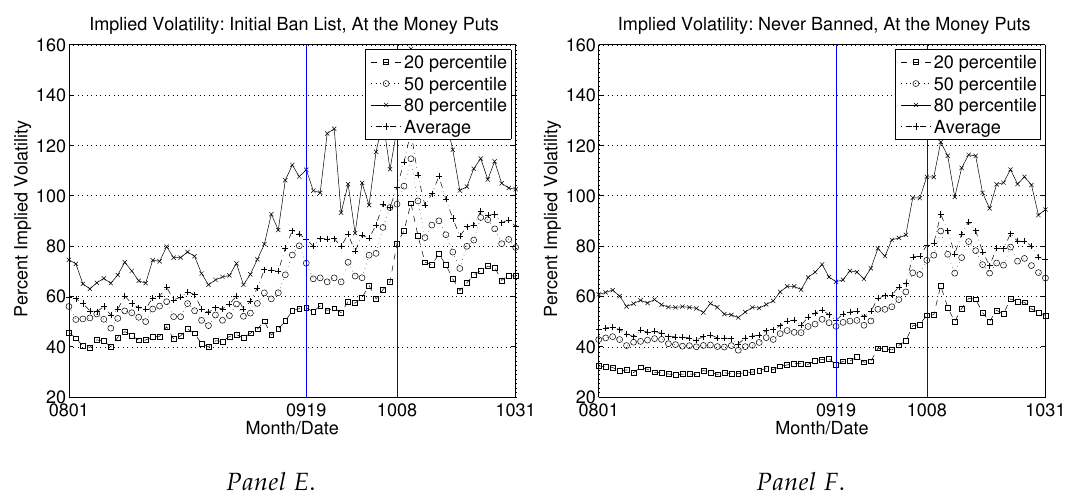
Figure 4. Time series of cross sectional options summary statistics. At the money put options of Initial Ban List and Never Banned Stocks during the ban and non-ban periods: ( A , C , E ) results for the three variables for Initial Ban List Stocks; and ( B , D , F ) results for the three variables for Never Banned